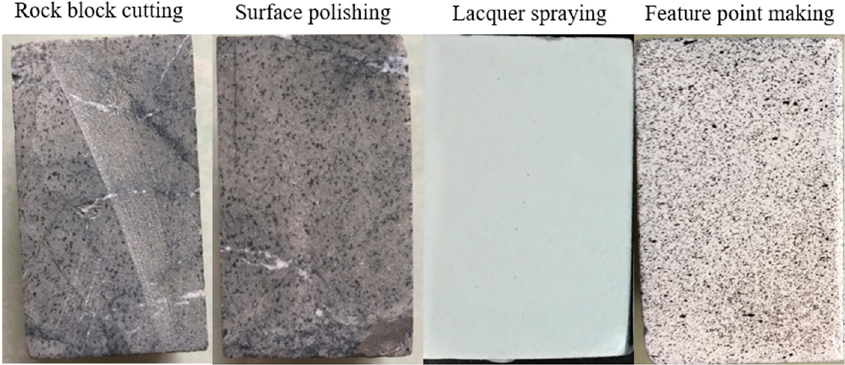
Figure 3. Flow diagram of rock process.